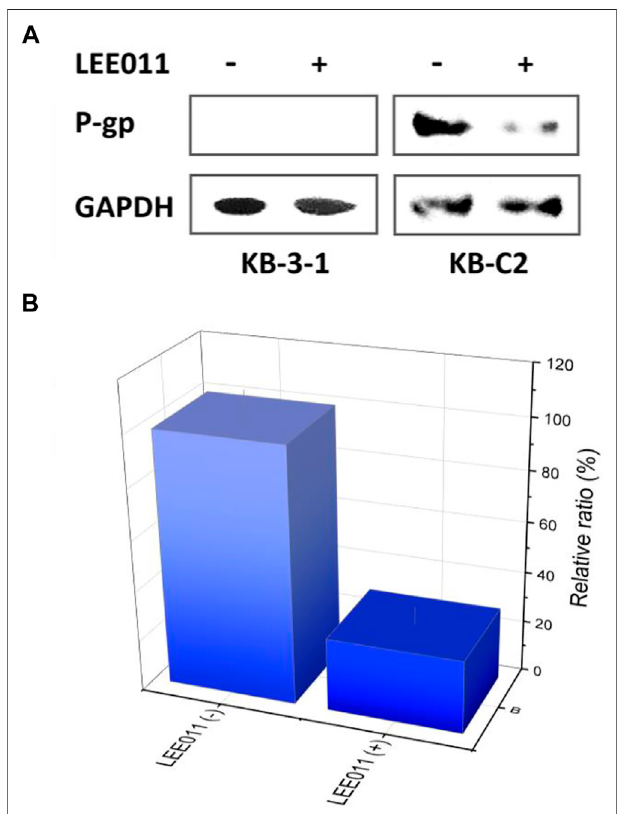
FIGURE 2 | ABCB1 expression deviation between the robociclib/ LEE011 treated KB-C2 cells and the robociclib non-treated KB-C2 cells. (A) Western blot indicated that P-gp expression was signi fi cantly downregulated by incubating the cells with 9 µM of ribociclib for 48 h (B) ABCB1 mRNA levelwasanalyzedbyRT-q-PCR,using GAPDH mRNAastheinnerreference. The cells without robociclib treatment were set as